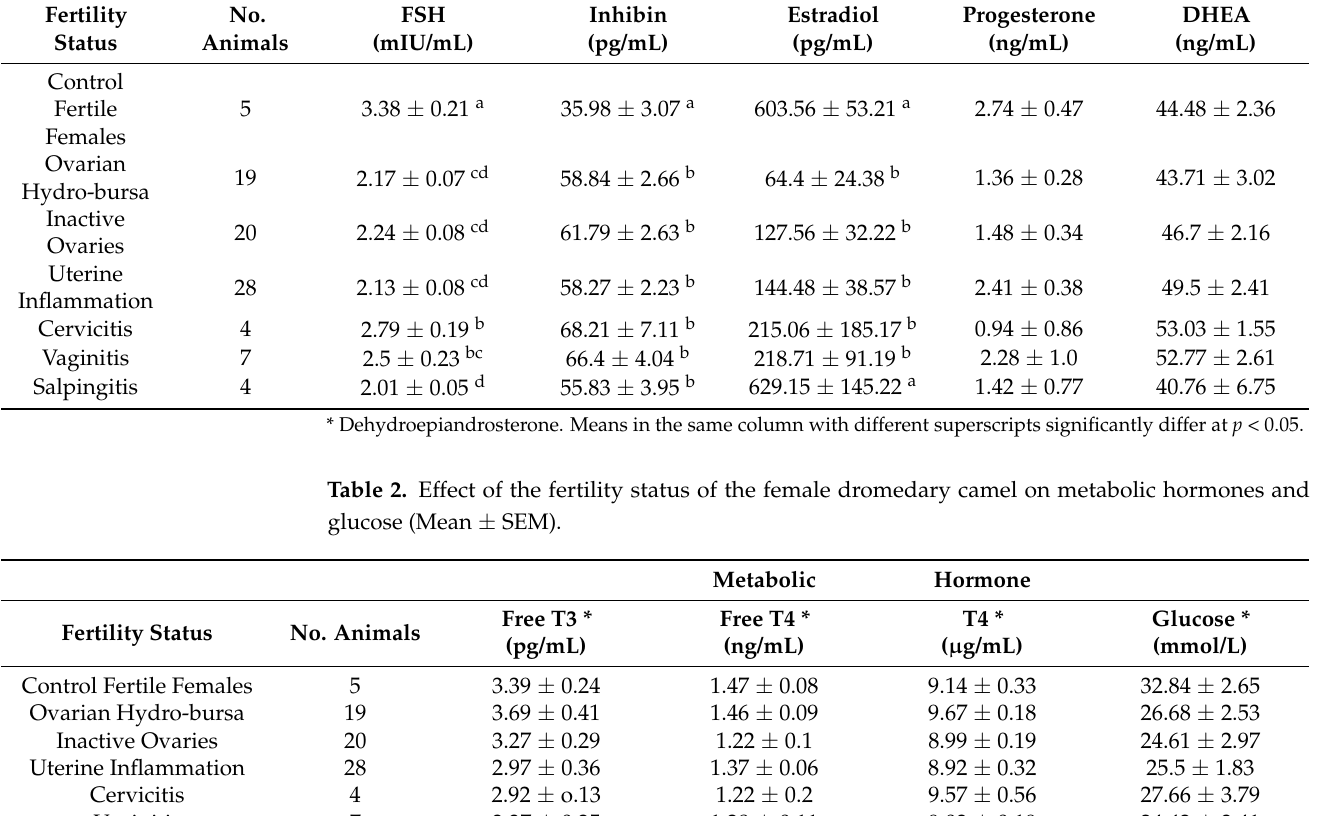
Table 1. Effect of the fertility status of the female dromedary camel on reproductive hormones as FSH, inhibin, estradiol-17ß, progesterone, and DHEA* (Mean ± SEM). Reproductive Hormone FSH Inhibin Estradiol Progesterone (pg/mL) (pg/mL)